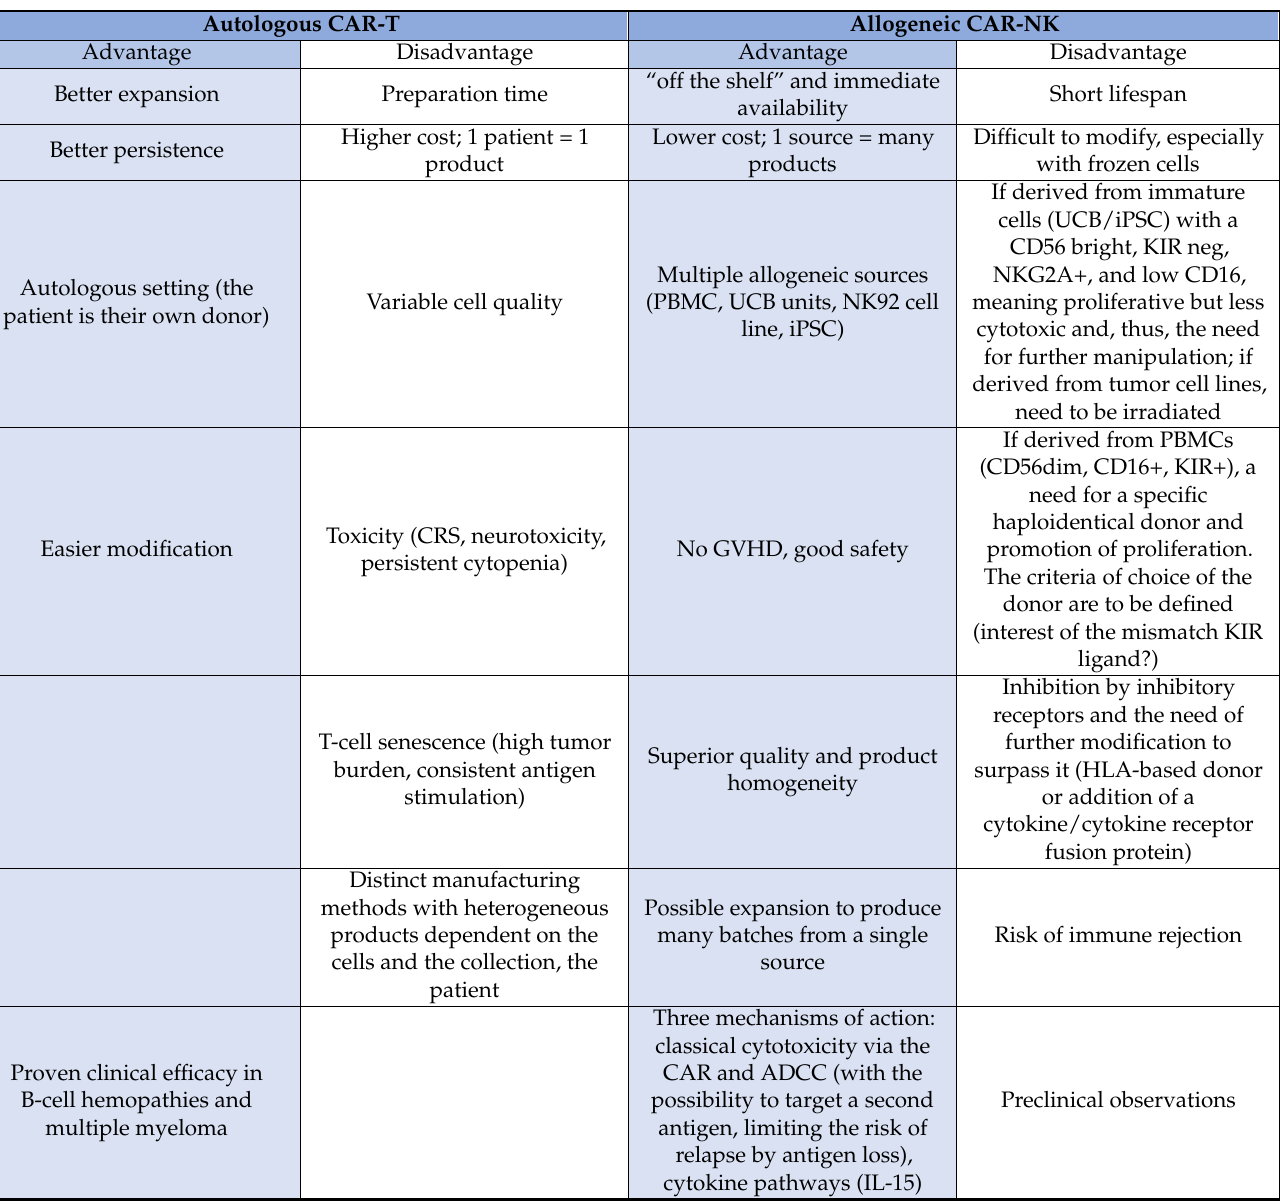
Table 1. Advantages and disadvantages of autologous CAR-T cells and allogeneic CAR-NK